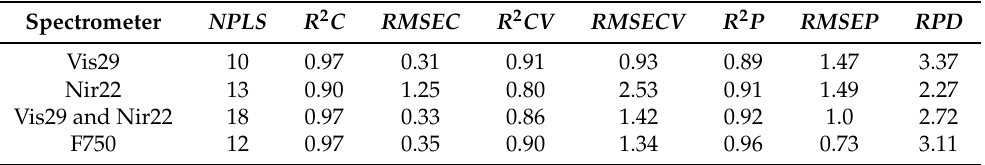
Table 4. Comparison of models. First three lines: our hardware set up, last line: F750 by Felix instruments. Where applicable, the unit % Brix is